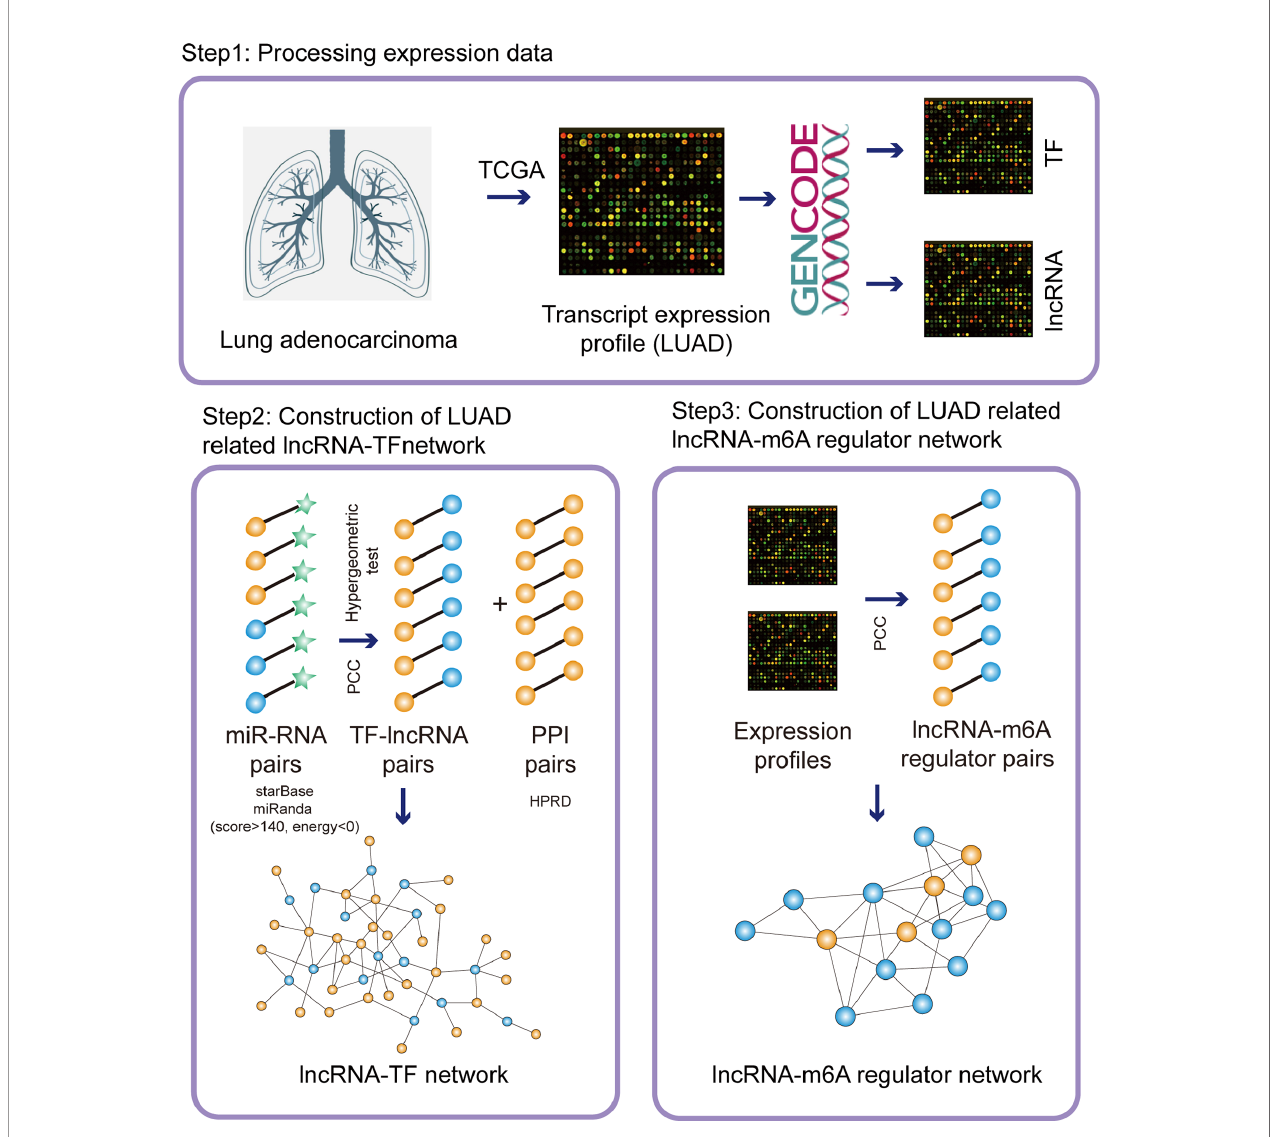
FIGURE 1 | The pipelines of network construction. Firstly, we downloaded the transcripts expression from TCGA database and separated the lncRNA/TF expression. Secondly, we integrated miRNA-RNA interactions, co-expressed lncRNA-TF pairs, and PPI network to construct LUAD-related lncRNA-TF network. Thirdly, we integrated co-expressed lncRNA-m6A regulator pairs to construct LUAD-related lncRNA-m6A regulator